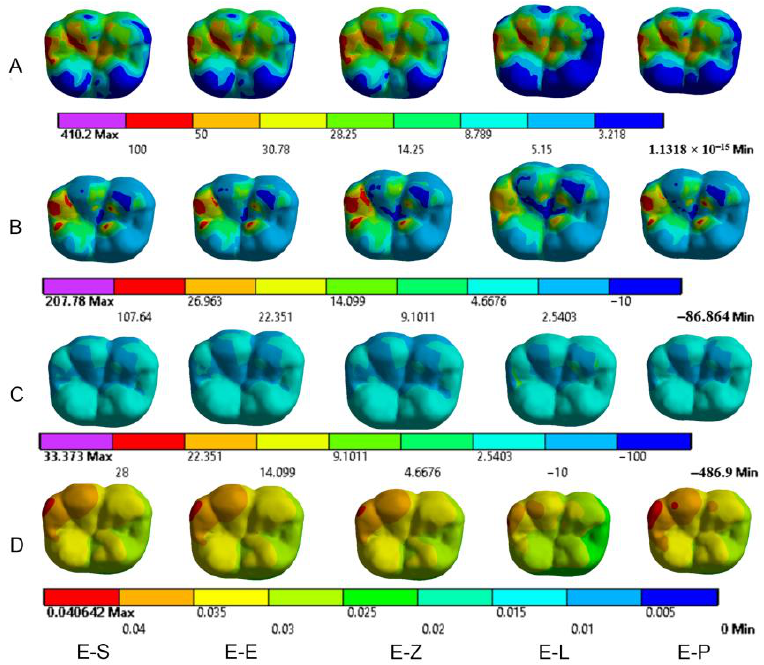
Figure 3. Stress distribution and displacement of endocrowns in all models under axial loading. ( A ) von Mises stress, ( B ) maximum principal stress, ( C ) minimum principal stress and ( D ) displacement. E-S: zirconia-reinforced lithium silicate ceramic model, E-E: lithium disilicate glass ceramic model, E-Z: translucent zirconia model, E-L: resin nanoceramic model and E-P: polymer-infiltrated ceramic network model.